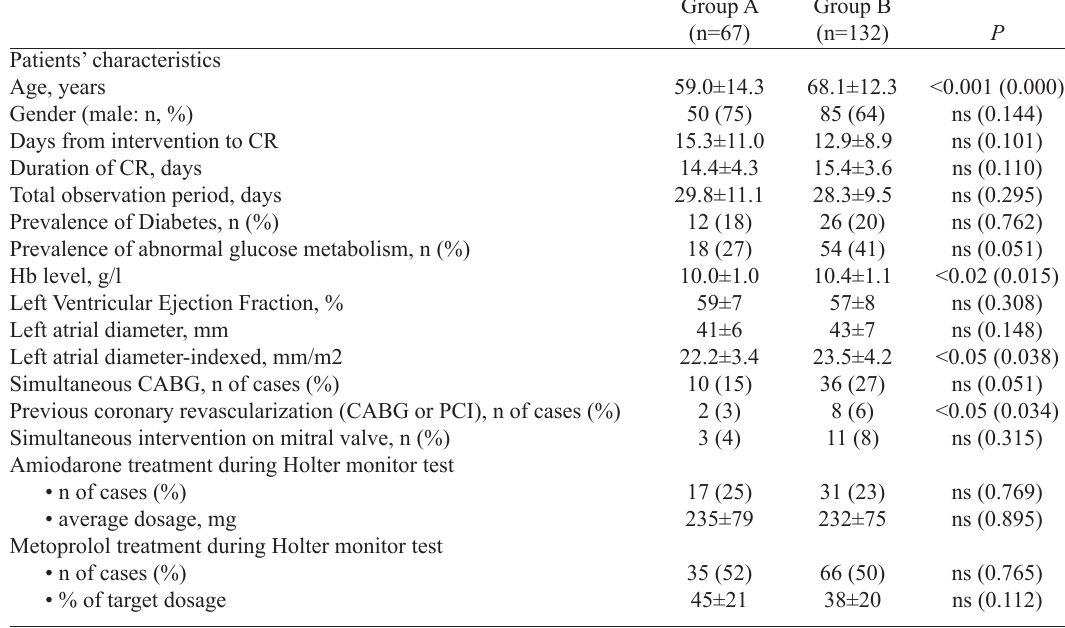
Table 1. Patients